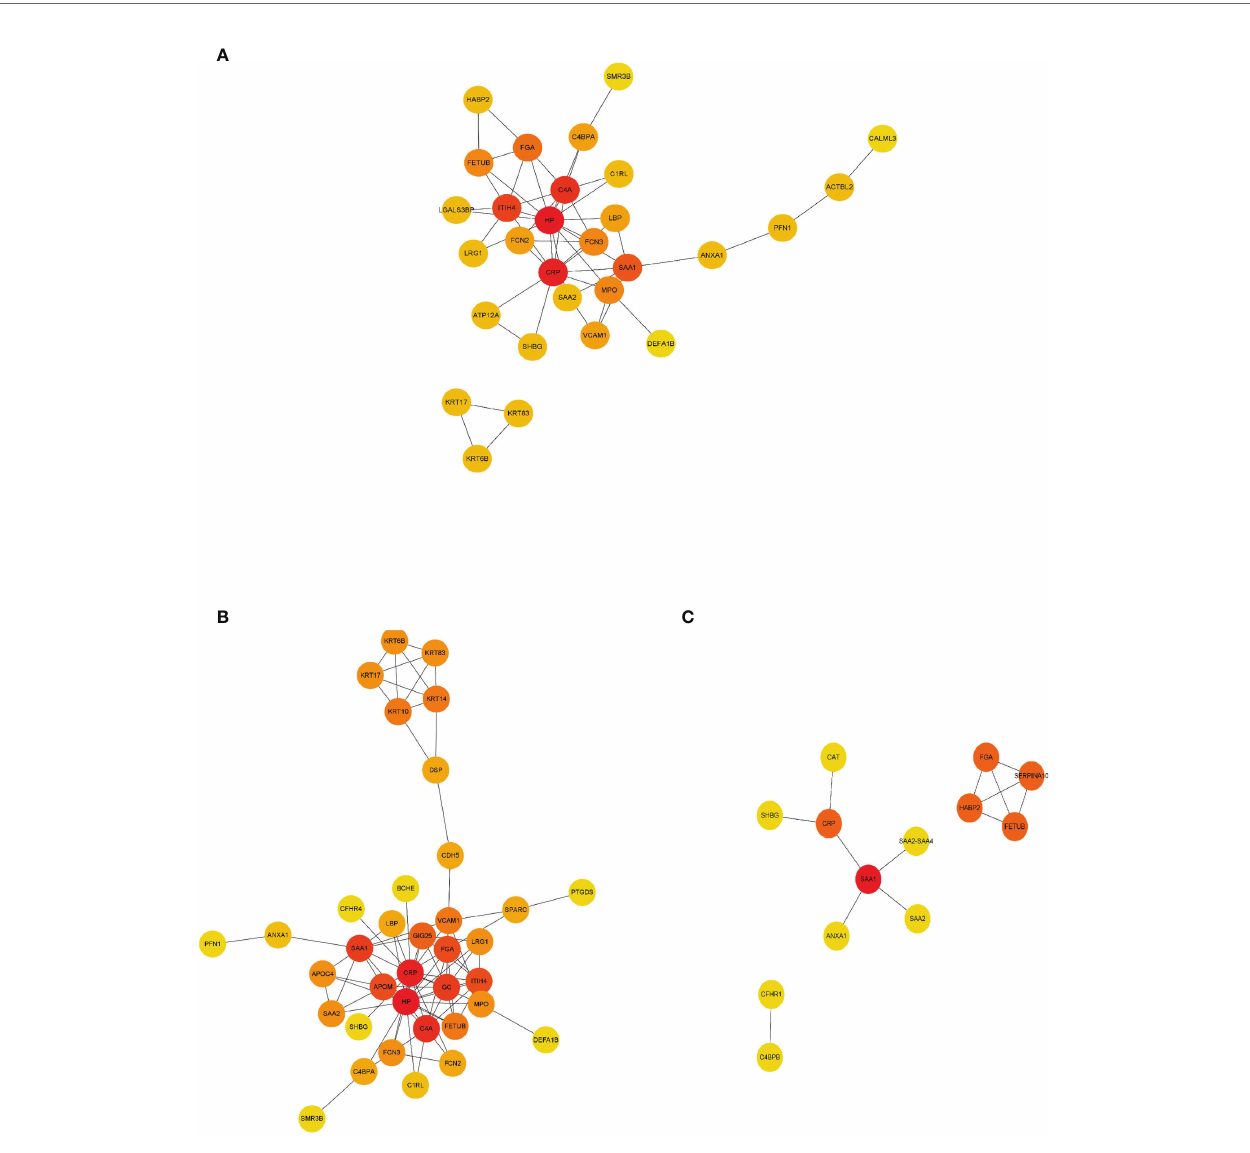
FIGURE 5 | PPI network construction of DEPs. Interaction network analysis of DEPs in RA (A) , ACPA-positive RA (B) , and ACPA-negative RA (C) by STRING and Cytoscape. Cytohubba plug-in was applied to identify the hub proteins in the network by protein degrees. Red indicated DEPs were at the center of the network and possessing 5 – 10 edges. Orange indicated DEPs possessing 3 – 5 edges. Yellow indicated DEPs possessing 1 to 2 edges. PPI, protein – protein